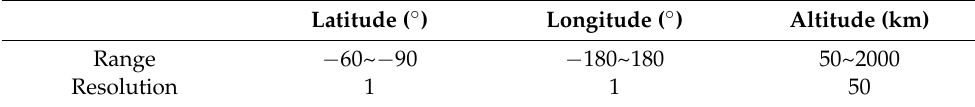
Table 1. Vertical electron density data.